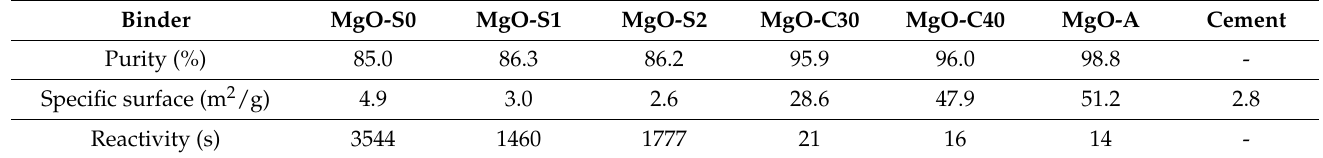
Table 1. Characteristics of the various reactive MgO and cement.